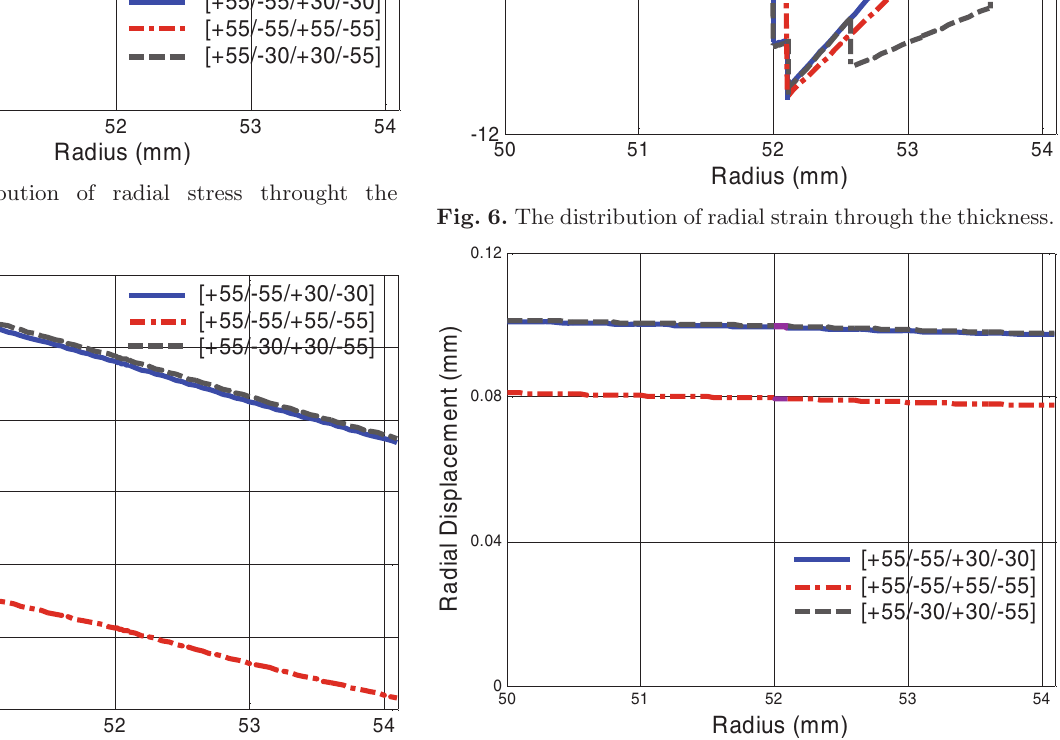
Fig. 5. The distribution of hoop strain through the thickness.